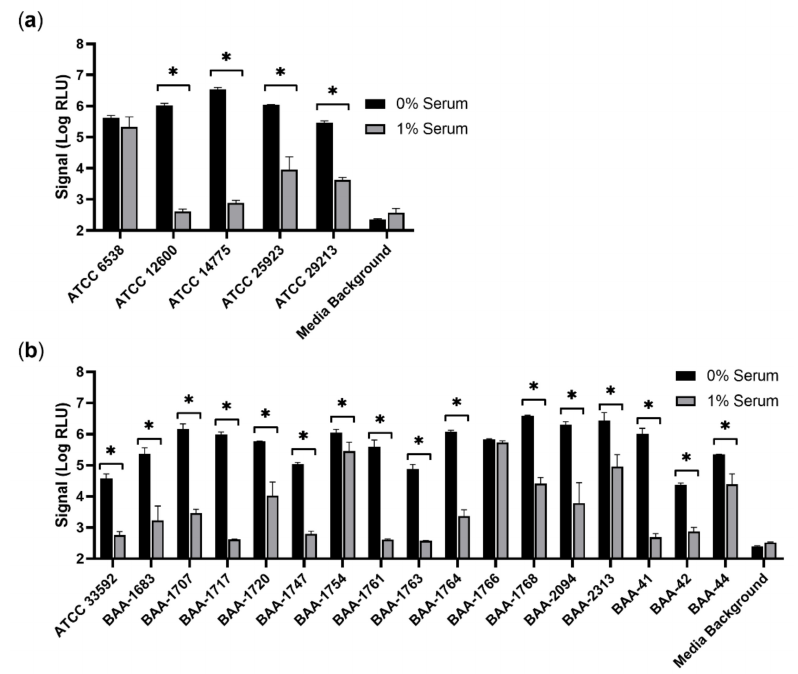
Figure 2. Phage-based reporter signal is reduced by serum in many S. aureus strains. A diverse panel of MSSA ( a ) and MRSA ( b ) strains was evaluated for luciferase production following a 4 h enrichment and a 2 h infection in the presence or absence of 1% off-the-clot human serum. Initial inoculum was approximately 100 CFU per well. Signal is provided as log-transformed relative light units (Log RLU). Error bars represent standard deviation from triplicate wells. A two-way ANOVA with a Bonferroni’s multiple comparisons test was performed, comparing 0% and 1% serum conditions for each sample. Asterisks (*) indicate significance ( p <